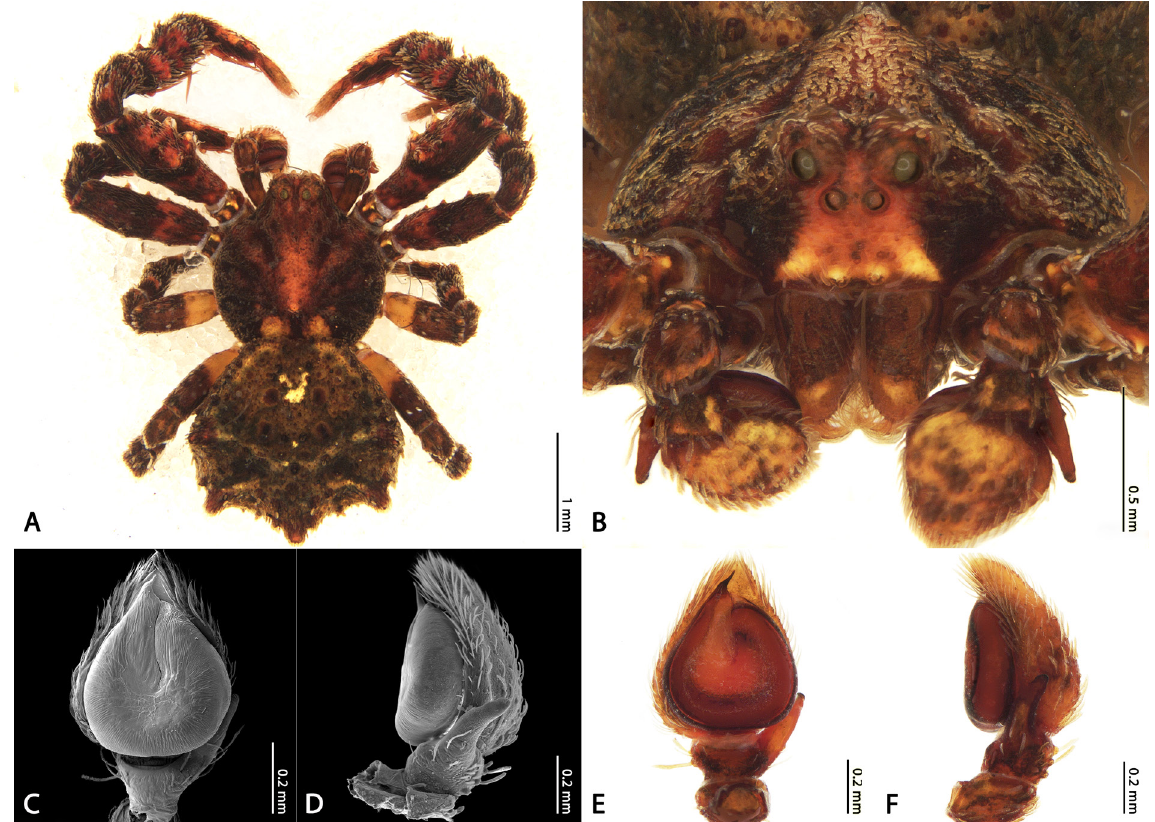
Fig. 11. Male of Kryptochroma pentacantha (Mello-Leitão, 1929) gen. et comb. nov. (MCTP 25762). A . Habitus, dorsal view. B . Front. C–F . Left male palp. C, E . Ventral view. D, F . Retrolateral